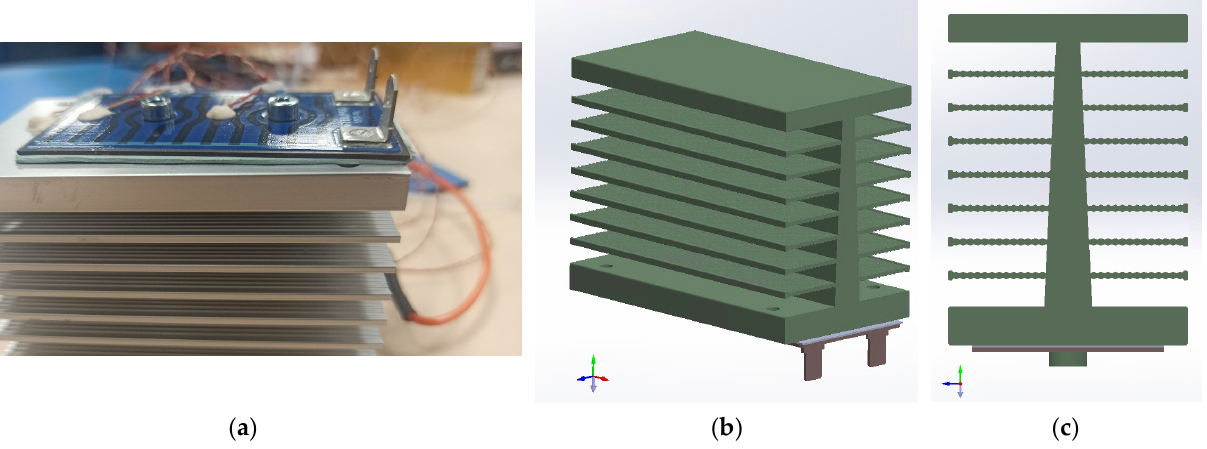
Figure 6. ( a ) Measurement of Setup 3 with thermal pad added; ( b ) Isometric view of simulated model of Setup 3 and gravity orientation; ( c ) Side view of Setup 3.